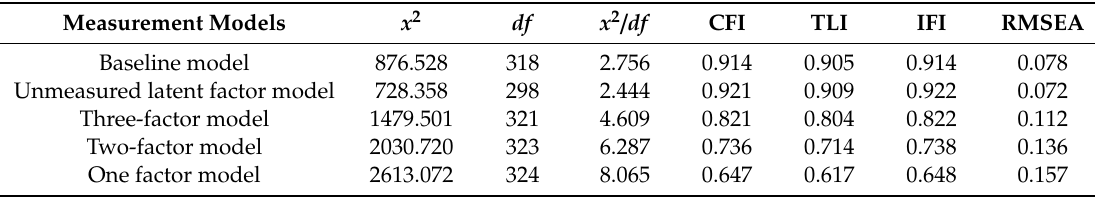
Table 2. Results of confirmatory factor